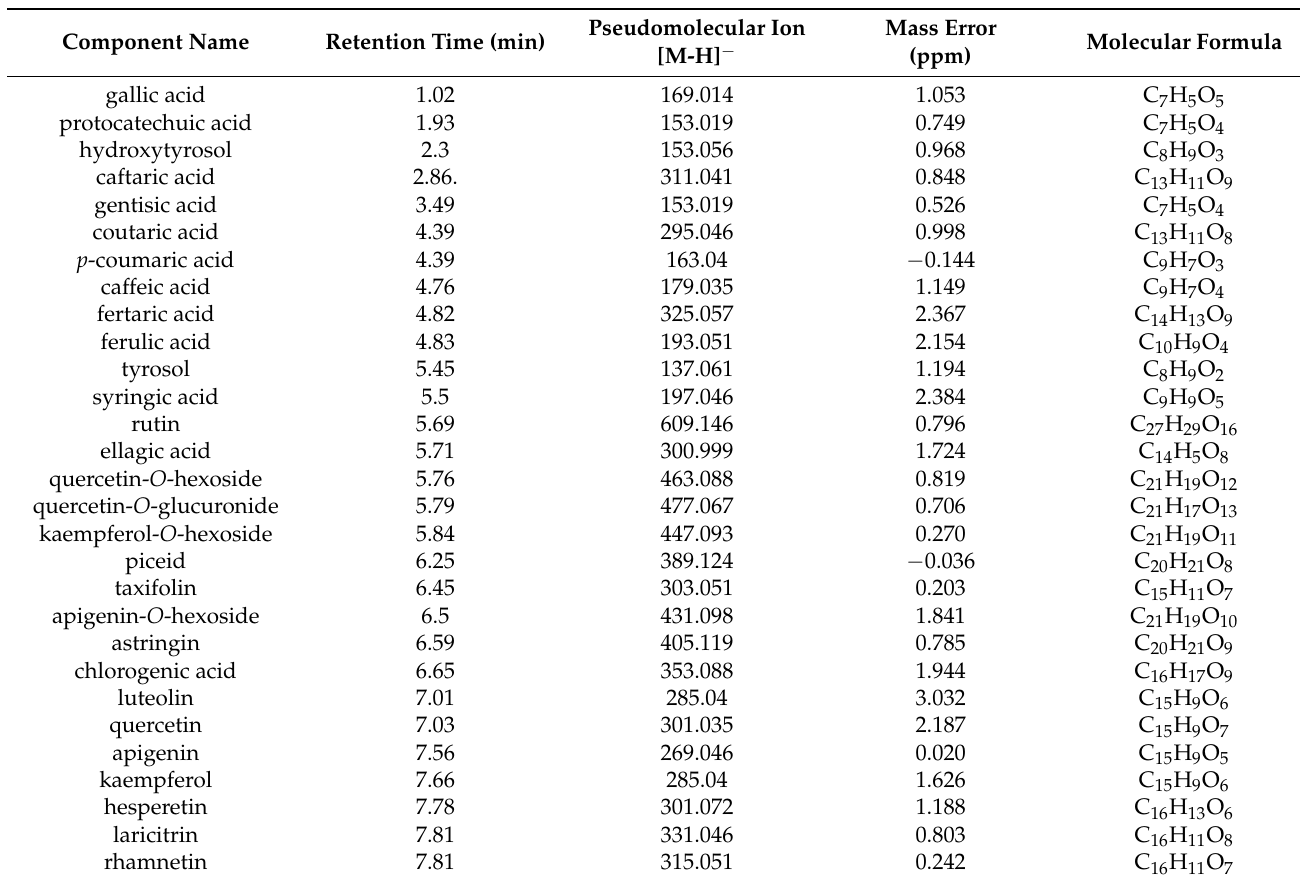
Table 1. List of compounds included in the inter-sample